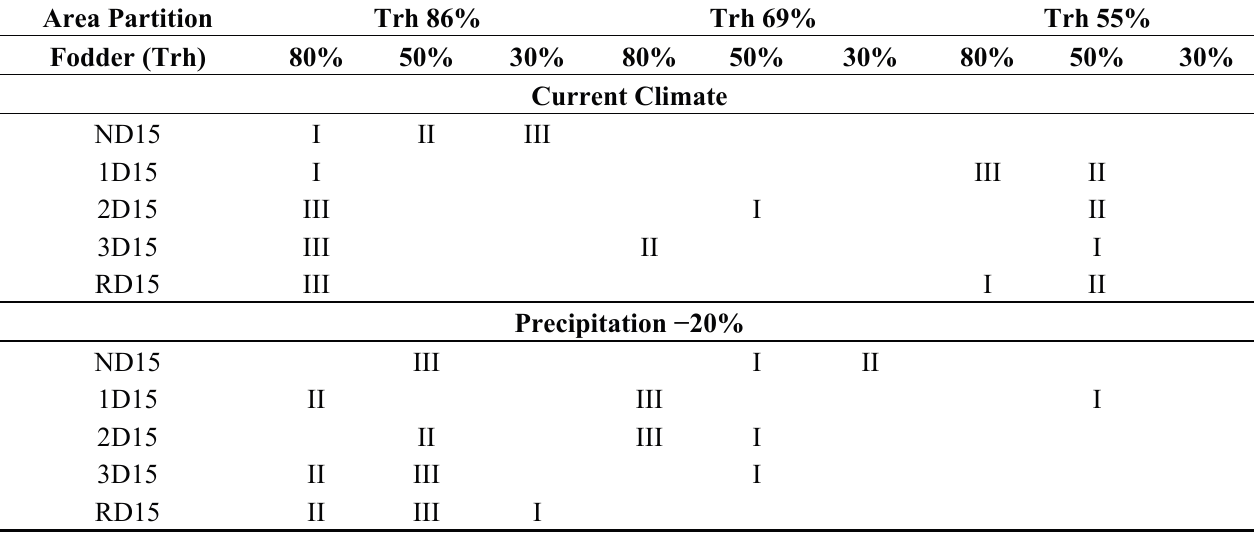
Table 2. Comparison of investigated scenarios concerning their performance on cumulative 15-years income generation from pastoral livestock